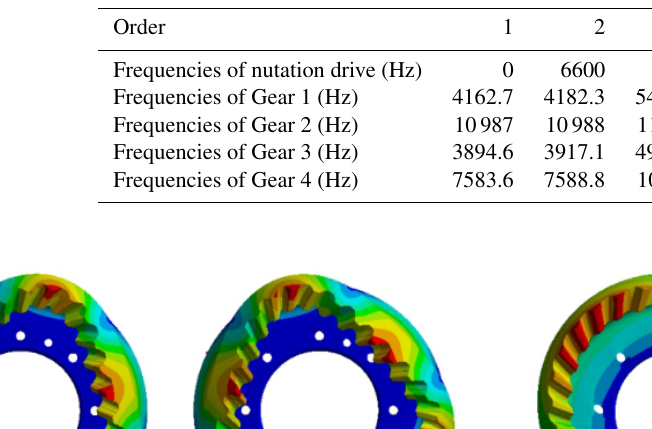
Table 5. Comparison of low-order natural frequencies between nutation drive system and bevel gears.